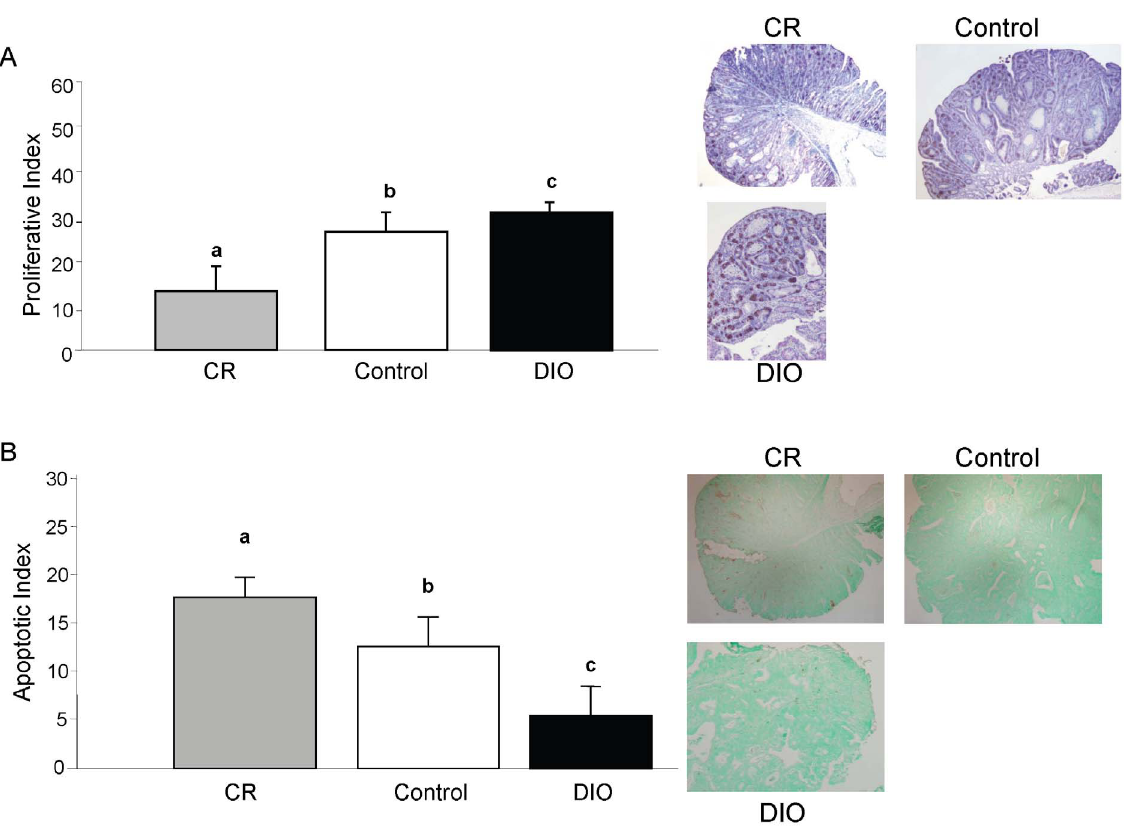
Figure 6. Cellular proliferation and apoptosis in CR, control, and DIO mice 20 weeks after the last AOM injection. A ) Proliferation was assessed via immunohistochemistry for proliferating cell nuclear antigen (PCNA). A field of 1000 cells was counted for each animal and the proliferative index represents the percentage of cells that stained positive for PCNA. The bars represent the average proliferative index for each dietary group (n=20). B ) Apoptosis in the tumors of LID versus wildtype mice 20 weeks after the last AOM injection. Apoptosis was assessed via TUNEL staining. A field of 1000 cells was counted for each animal and the apoptotic index represents the percentage of cells that stained positive and also appeared apoptotic based on cell morphology. The bars represent the average apoptotic index for each dietary group (n=20). a , b , and c represent dietary treatments that are significantly different (p , 0.05) from one another as determined by a Bonferroni test.